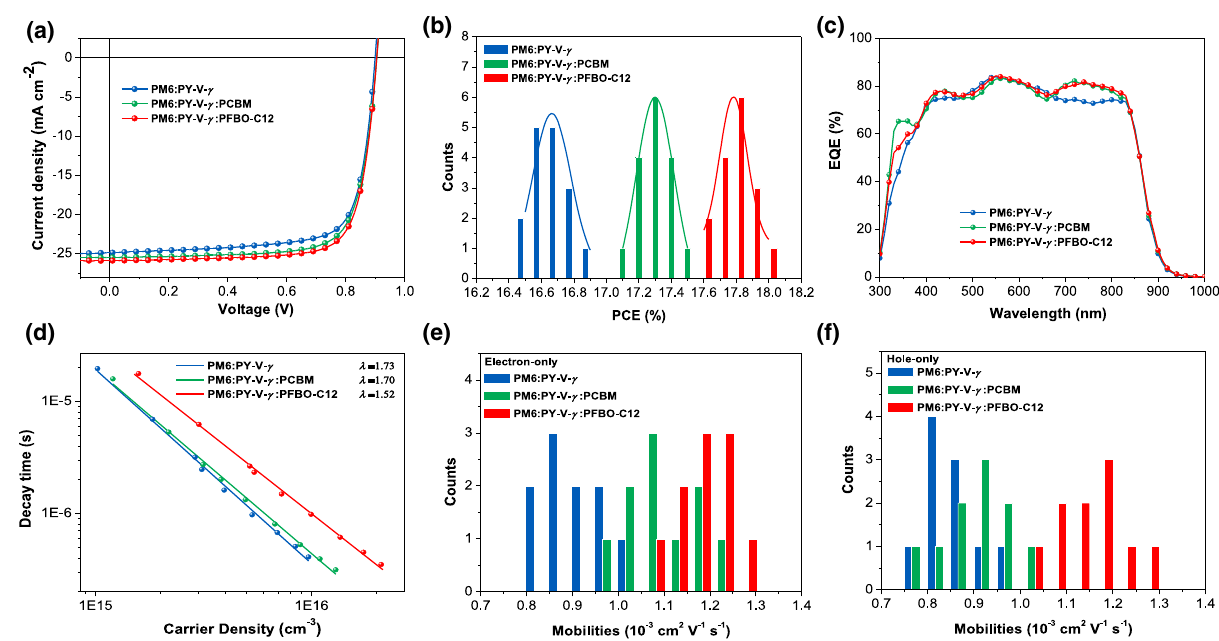
Fig.2|Photovoltaicperformance,chargerecombination,andcarriermobility. a Current density – voltage ( J – V ) characteristics, b power conversion ef fi ciency (PCE) statistical histograms, c external quantum ef fi ciency (EQE) spectra, and d transient photovoltage (TPV) decay time as a function of carrier density of three